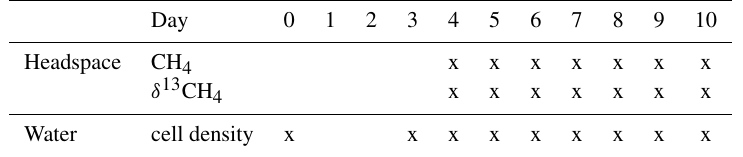
Table 1. Overview of sample collection during the incubation of E. huxleyi .